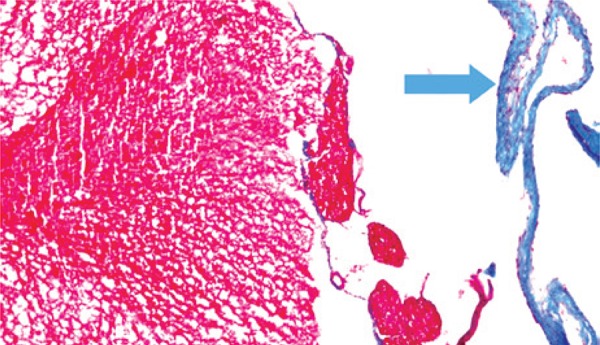
Fotomicrografia de um rato do Grupo Tela (tricromo de Masson, 200X). A seta indica espessamento fibroide da dura-máter corado em azul